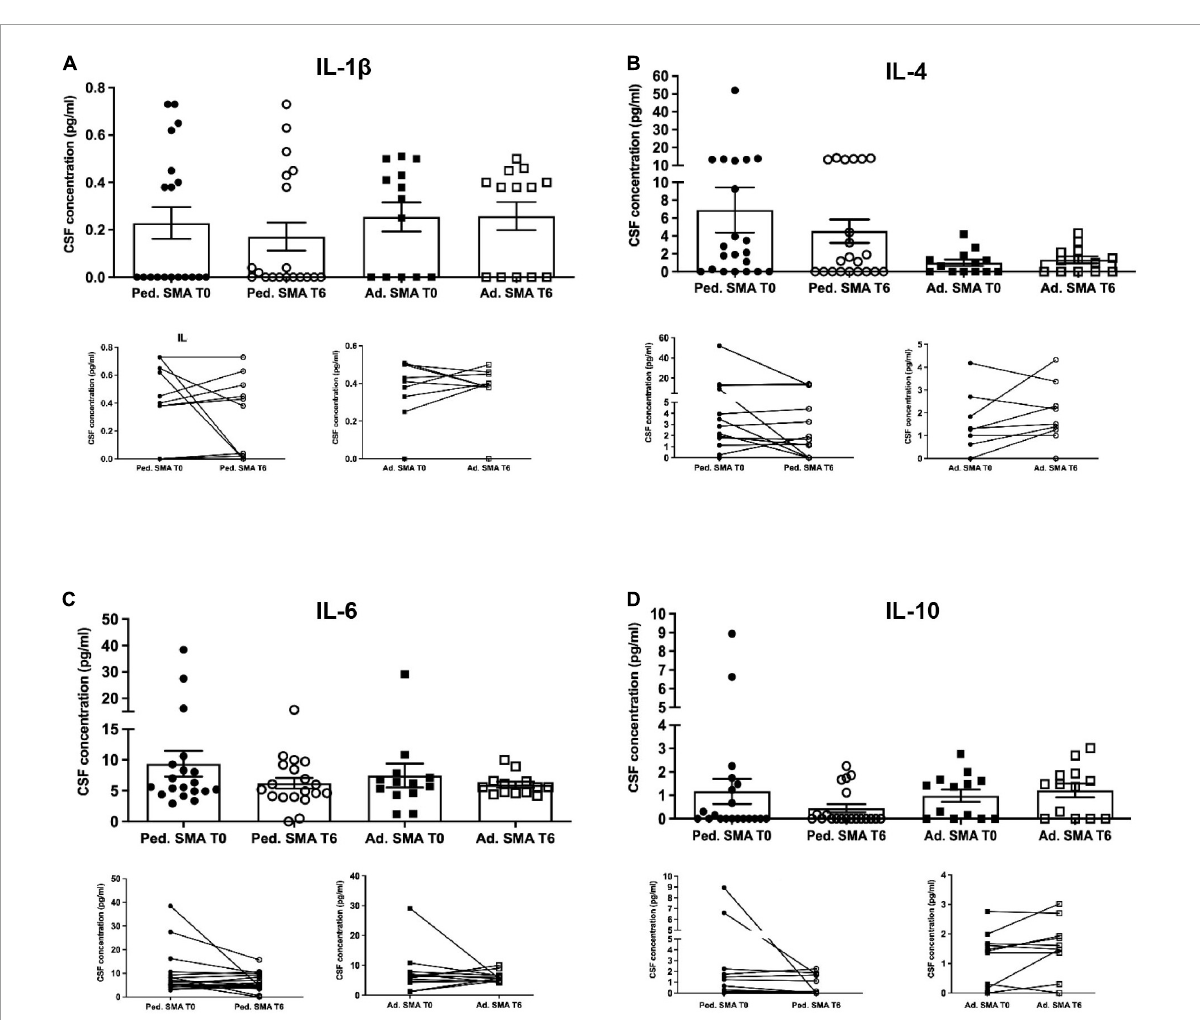
FIGURE4 Levels of cytokines in cerebrospinal fluid (CSF) of pediatric and adult spinal muscular atrophy (SMA) patients. The concentration (pg/ml) of (A) IL-1 β , (B) IL-4, (C) IL-6, and (D) IL-10 was measured in the serum of pediatric (Ped.; circle, N = 21) and adult (Ad.; square, N = 13) SMA patients at baseline (T0 black) and after 6 months of nusinersen treatment (T6 white), and in healthy control (Ad. CTR; gray triangle) by multiplex immunoassay. Data in the graphs are reported as mean ± SEM for each sample group. The before-after graphs contains the mean cytokine concentration obtained for each patient in the duplicate multiplex immunoassays reactions before and after 6 months of nusinersen treatment (T0 and T6). p > 0.05, Mann–Whitney